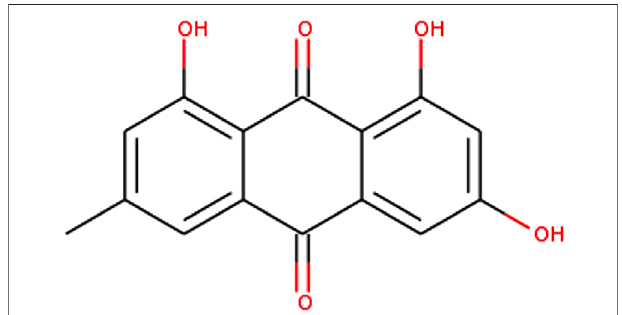
FIGURE 1 | Chemical structure of